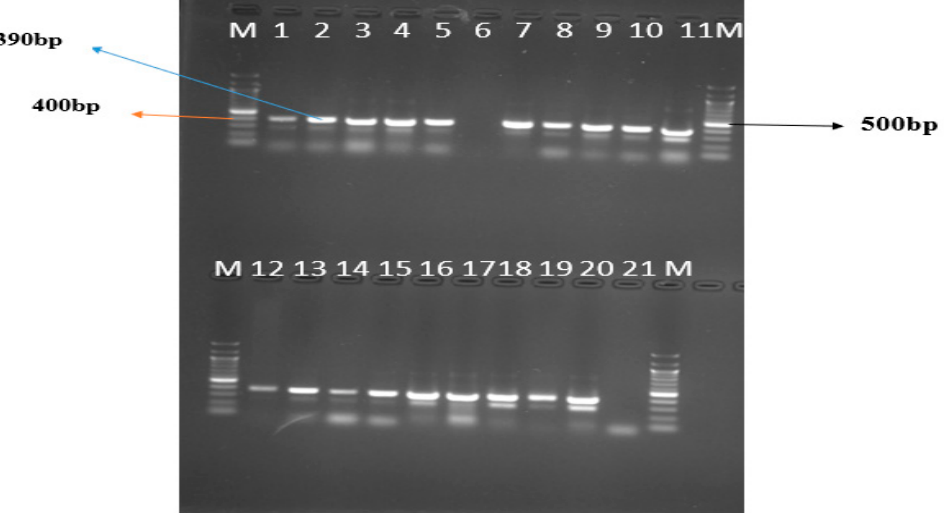
Figure 5. Lane M is the 100 bp marker, Lanes 1–20 are randomly selected Anopheles samples. Lane 21 = negative sample. Distinguishing band size: A. gambiae s.l at 390 bp; A. arabiensis 315 bp. After conditioning the PCR, samples 1 to 7 of randomly picked A. gambiae s.l showed DNA band sizes of 475 bp, authenticating the species to be A. gambiae s.s (Figure 6) Figure 6. Agarose gel 1.5% for distinguishing A. gambiae s.s and coluzzi after PCR with primers (R3, R5, B/Sint and MoPint). 3.4. Mosquito Behavioural Study The exposure of adult female A. gambiae to the essential oil from all six states and N, N -diethyl-3-methylbenzamide (DEET) for a period of 30 min at doses ranging from 0.1– 1% v / v was investigated and reported in Figures 7 and 8.